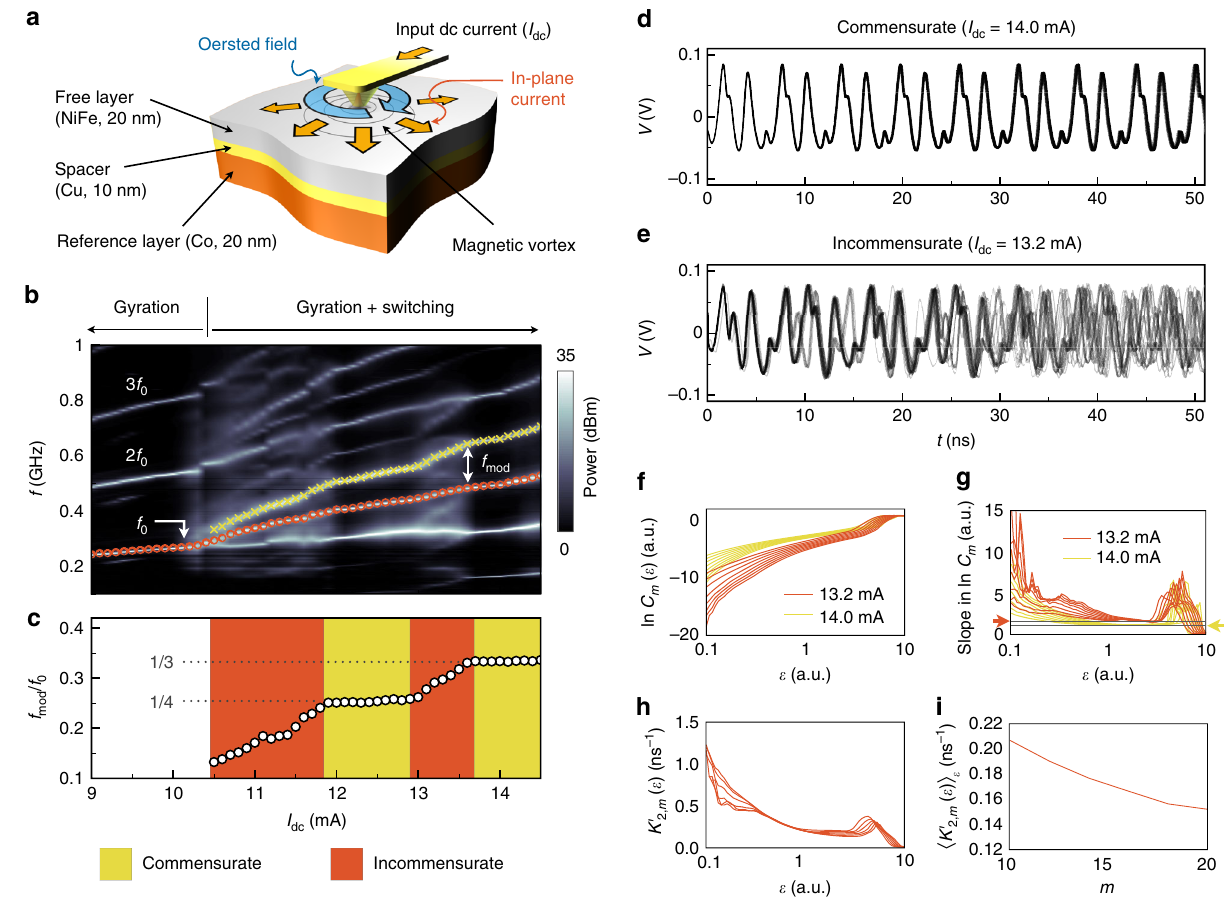
Fig. 1 Chaotic characteristics of the output time traces. a A schematic of a nanocontact vortex oscillator. b A map of the power spectra as a function of f input current amplitudes, I . The red circles and yellow cross marks indicate a fundamental frequency, f , and its upper sideband at f , respectively. 0 0 þ dc mod f = f I is a modulation frequency. c f . The yellow and red regions represent the commensurate and the incommensurate states, 0 as a function of mod mod dc respectively. The dotted horizontal lines indicate plateaus in which the self-phase-locking occurs. d Eighteen different time traces which have identical = 14.0 mA). e As in d but in the incommensurate state at I = 13.2 mA. f Correlation integrals C ϵ Þ as a initial conditions in the commensurate state ( I m ð dc dc function of a geometric scaling ϵ and g its derivatives of ∂ ln C m ð ϵ Þ = ∂ ln ϵ for embedding dimensions from m ¼ 10 (bottom curve) to m ¼ 24 (top curve) by = 13.2 and 14.0 mA, respectively. The horizontal lines indicated by red and yellow arrows correspond increment of 2. The red and yellow curves are for I dc ϵ Þ as a function of ϵ for embedding dimensions from m ¼ 10 (top curve) to estimate of D based on the fl ats in the scaling ϵ -interval ½ 1 ; 10 0 : 3 (cid:4) . h Metric K 0 2 ; m ð c ϵ Þi to m ¼ 24 (bottom curve) by increment of 2 at I 13 : 2 mA and i h K 0 in the scaling range ½ 1 ; 10 0 : 3 (cid:4) for the asymptotic determination of the 2 ; m ð dc ¼ ϵ